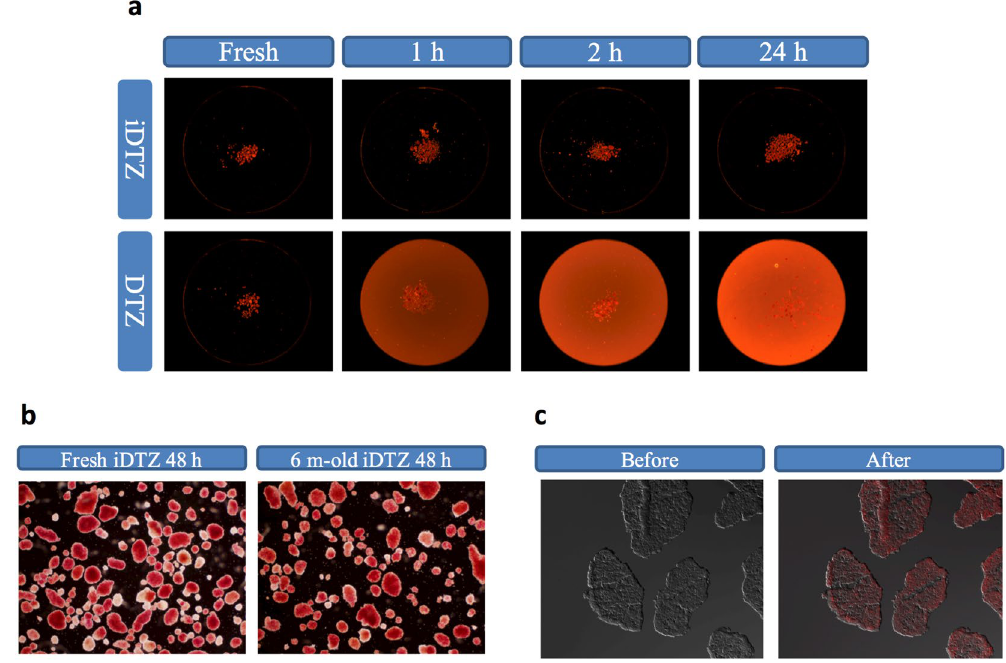
Figure 2. Solutions of iDTZ show improved islet staining under various conditions employing an automated quantification system. Human islets stained with iDTZ or standard DTZ solution visualized at the indicate time points ( a ). Human islets stained with fresh iDTZ solution and islets stained with iDTZ solution stored for 6 months at − 20 °C ( b ) and visualized 48 hours post-staining. Human islet cryo-sections were stained with iDTZ solution ( c ). Representative pictures from three experiments are shown. All the pictures were obtained using an Olympus